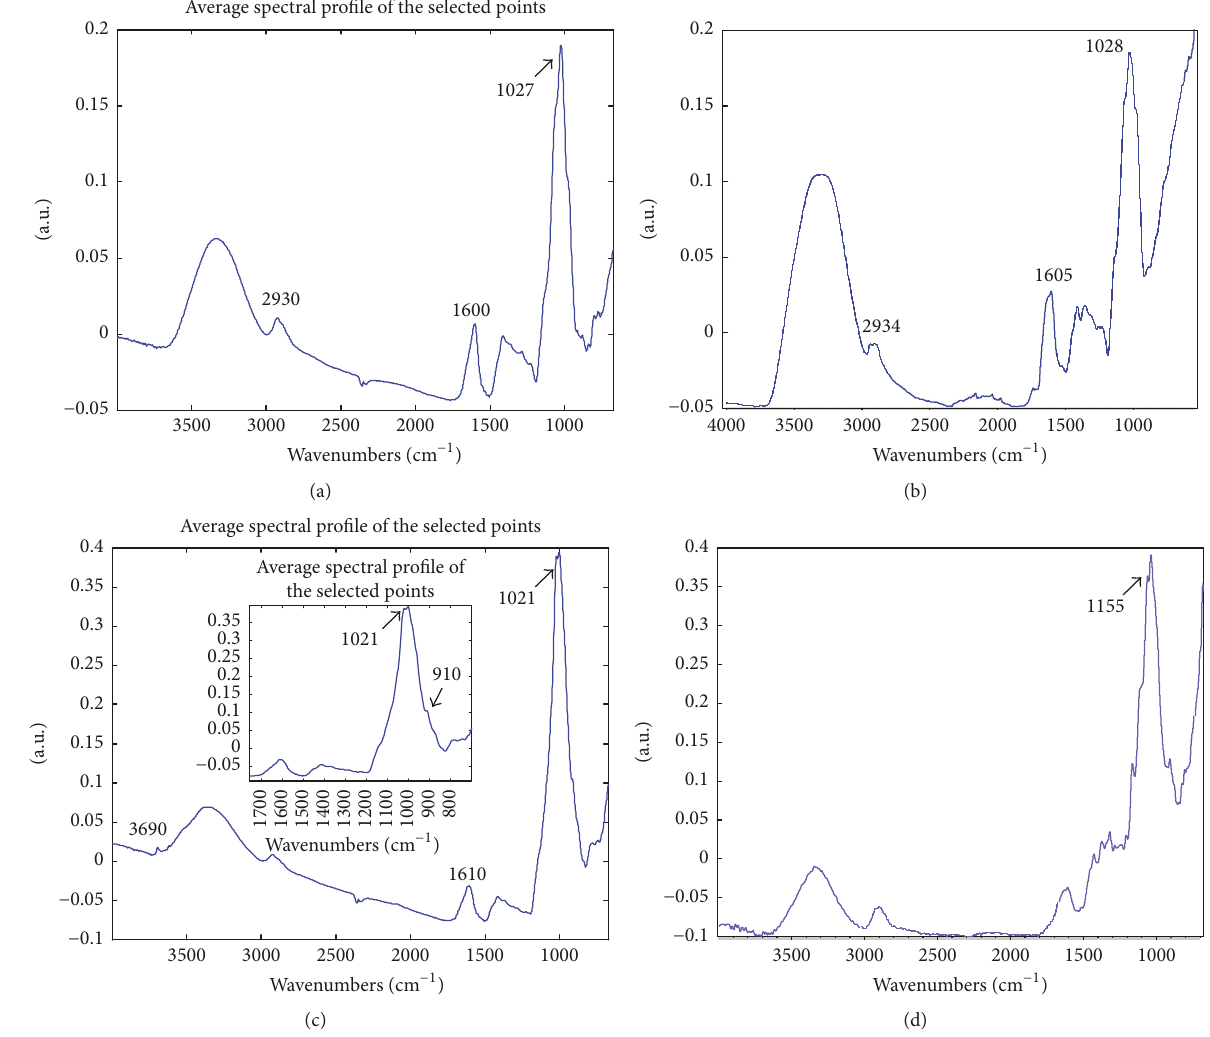
Figure 3: Sample 15r1. (a) Average spectral profile extracted from layer 2; (b) reference spectrum of a natural gum (peach gum purchased by Zecchi, Florence Italy); (c) average spectral profile extracted from layer 1; (d) average spectral profile extracted from layer